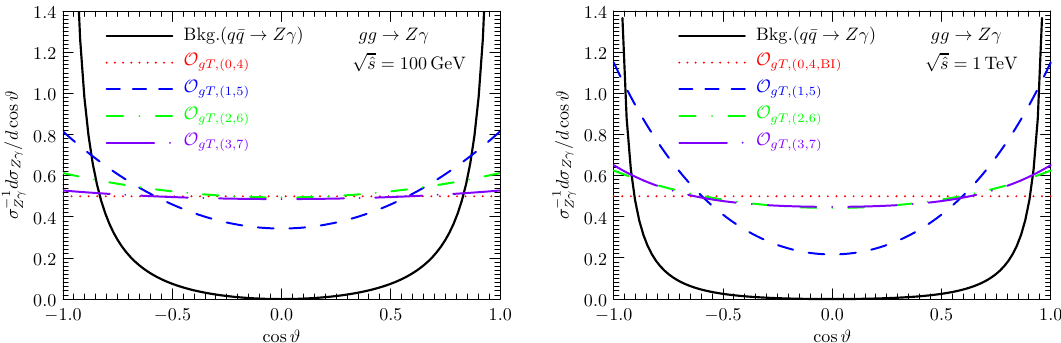
Figure 2 . Distributions in the normalized scattering angle cos ϑ for gg → Zγ scattering from the gQGC operators (colorful non-solid curves) and the SM background q ¯ q → Zγ (black solid curve). The energy dependences are seen by comparing the left (